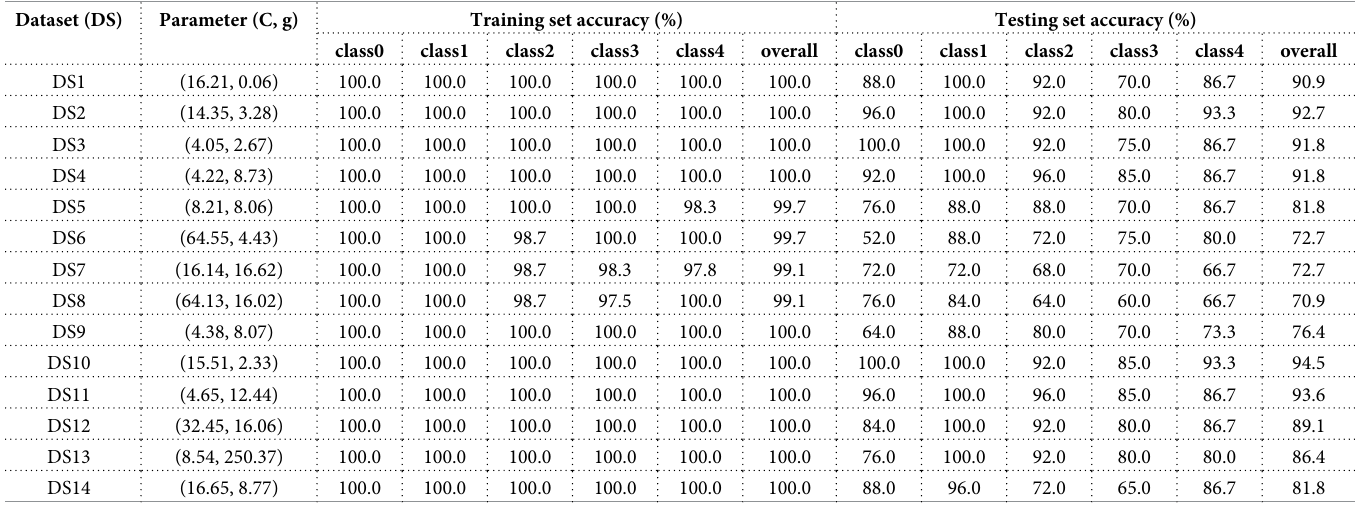
Table 6. Overall and individual class classification accuracies of SVM models with different datasets. Dataset (DS) Parameter (C,